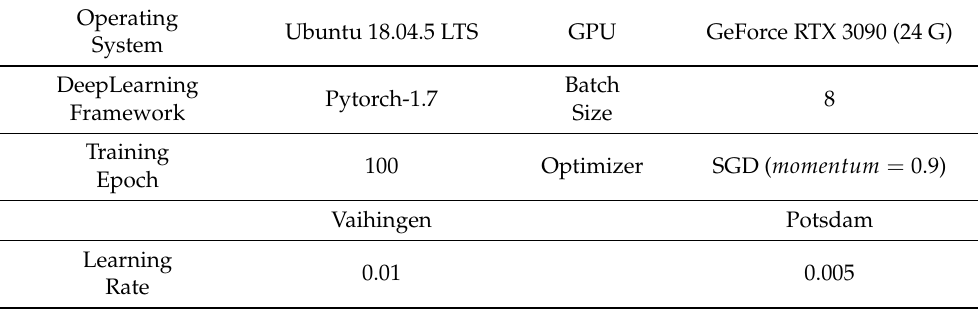
Table 2. Experimental